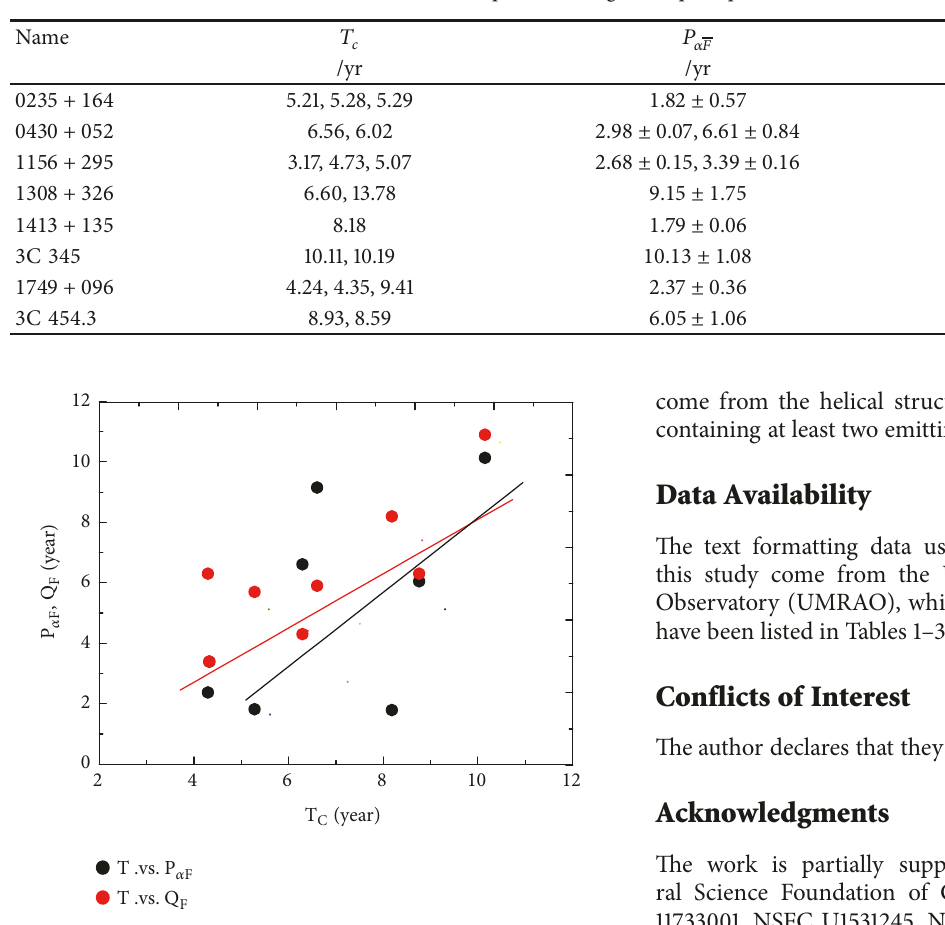
Figure6:Comparisonbetween 𝑇 𝑐 and 𝑃 𝛼𝐹 , 𝑄 𝐹 .Theblacklinestands for 𝑇 𝑐 vs. 𝑃 𝛼𝐹 , and the red line stands for 𝑇 𝑐 vs. 𝑄 𝐹 .